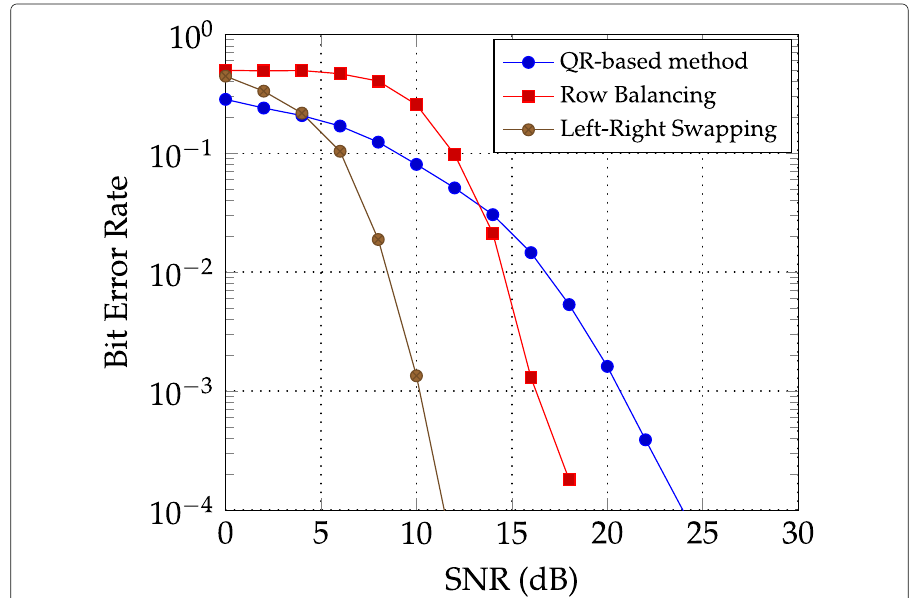
Fig. 7 BER comparison of LU-based scheme and QR-based